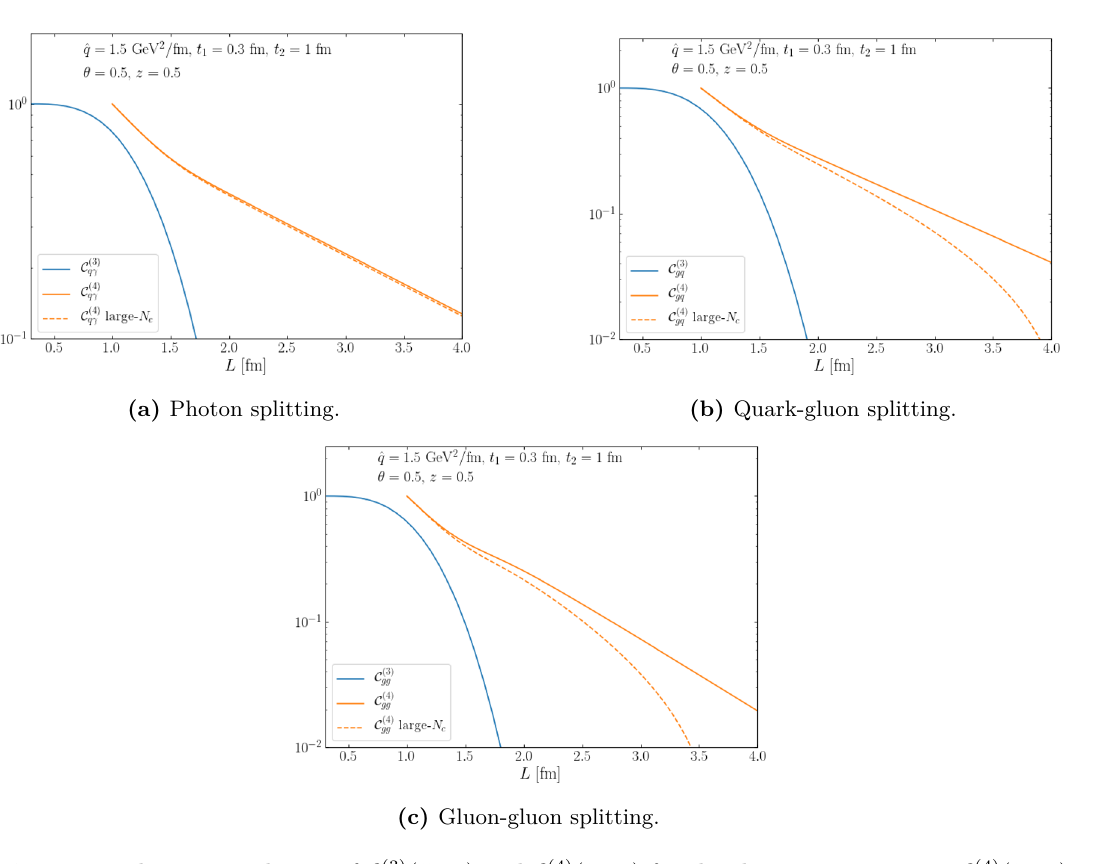
Figure 2. The time evolution of C (3) ( L, t 1 ) and C (4) ( L, t 2 ) for the three processes. For C (4) ( L, t 2 ) both the exact and large- N versions are c